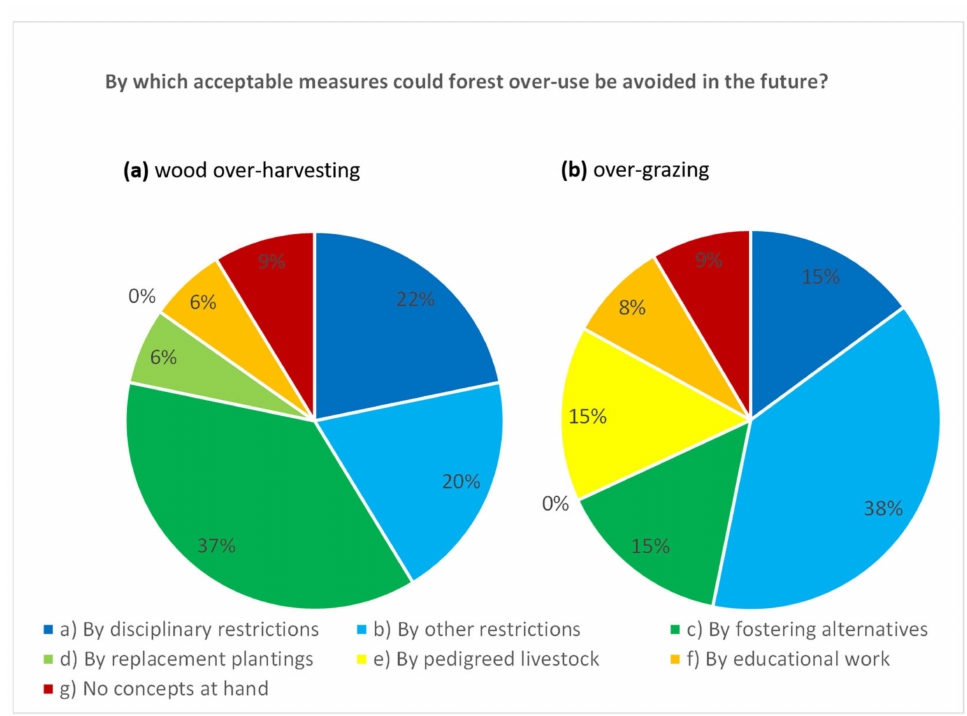
Figure 9. Assessment of Ak-Tal Village inhabitants regarding acceptable measures to prevent future forest over-use ( a ) referring to wood over-harvesting and ( b ) referring to over-grazing (Ak-Tal HHS